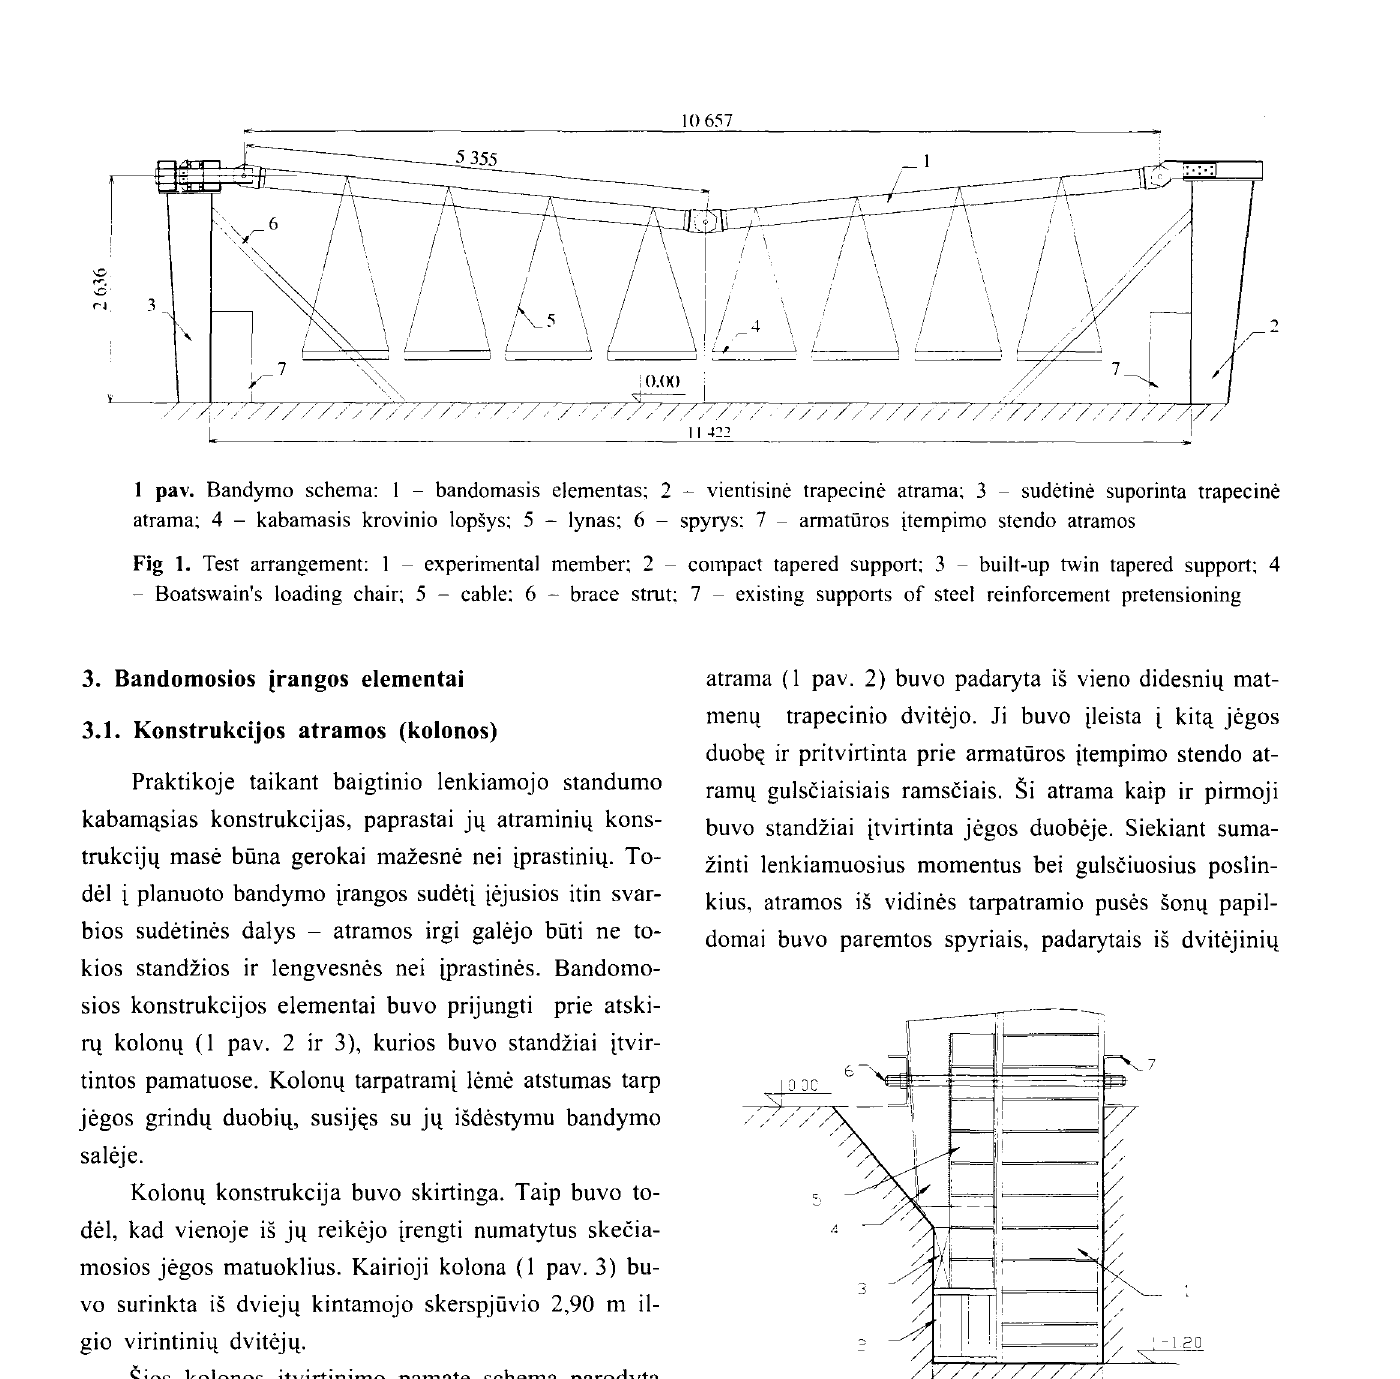
2 pav. Trapecines kolonos itvirtinimo pamate schema: I - armatiiros itempimo stendo atrama: 2 - plienine atramine deze: 3 - atramine plieno plokste (f = 50 mm): 4 - trapecinis virintinis dvitejis: 5 - lovys Fig 2. Arrangement of tapered column fixation in foundation: I - existing support of test bench for pretensioning reinforcing bars: 2 - steel